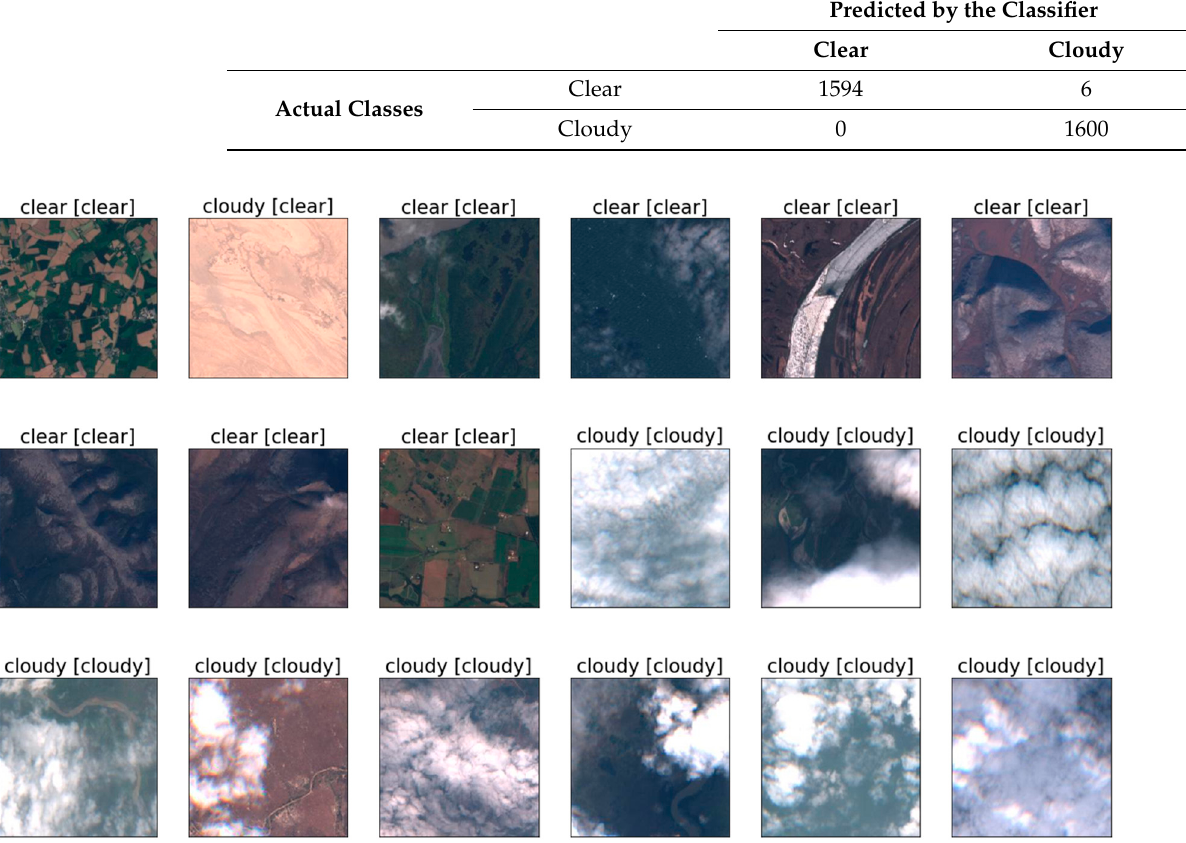
Figure 5. Predicted and Actual Classes of Sample Images in the Test Set.